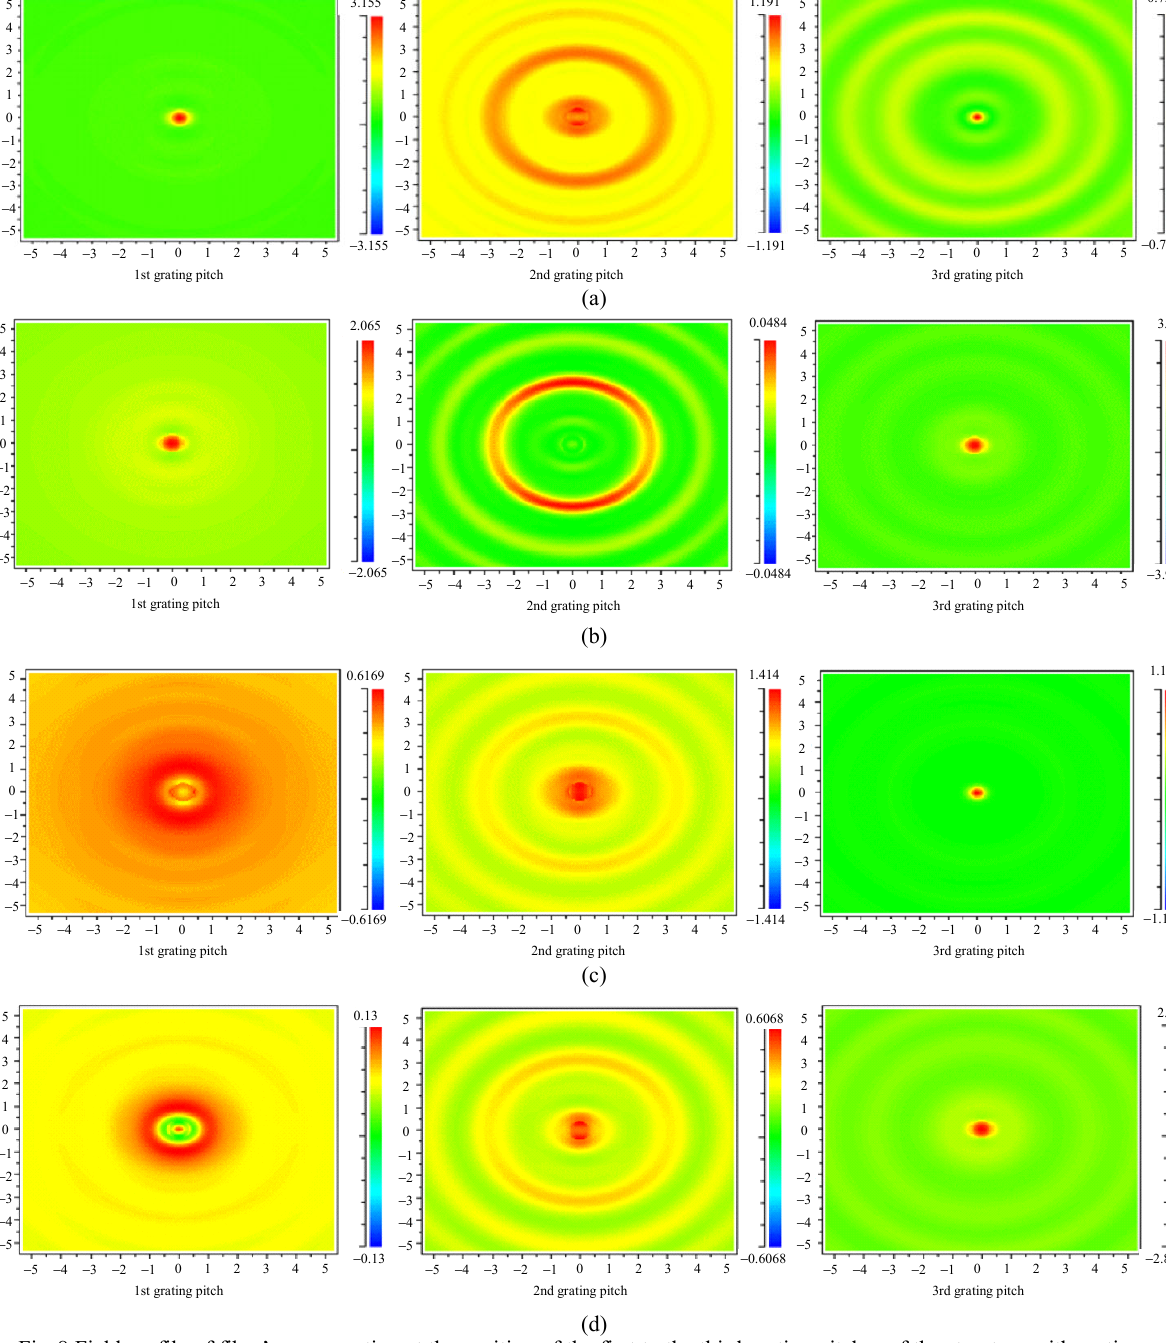
Fig. 8 Field profile of fiber’s cross section at the position of the first to the third grating pitches of the structure with grating period of (a) 5.2 μ m, (b) 5.5 μ m, (c) 5.8 μ m, and (d) 6.1 μ